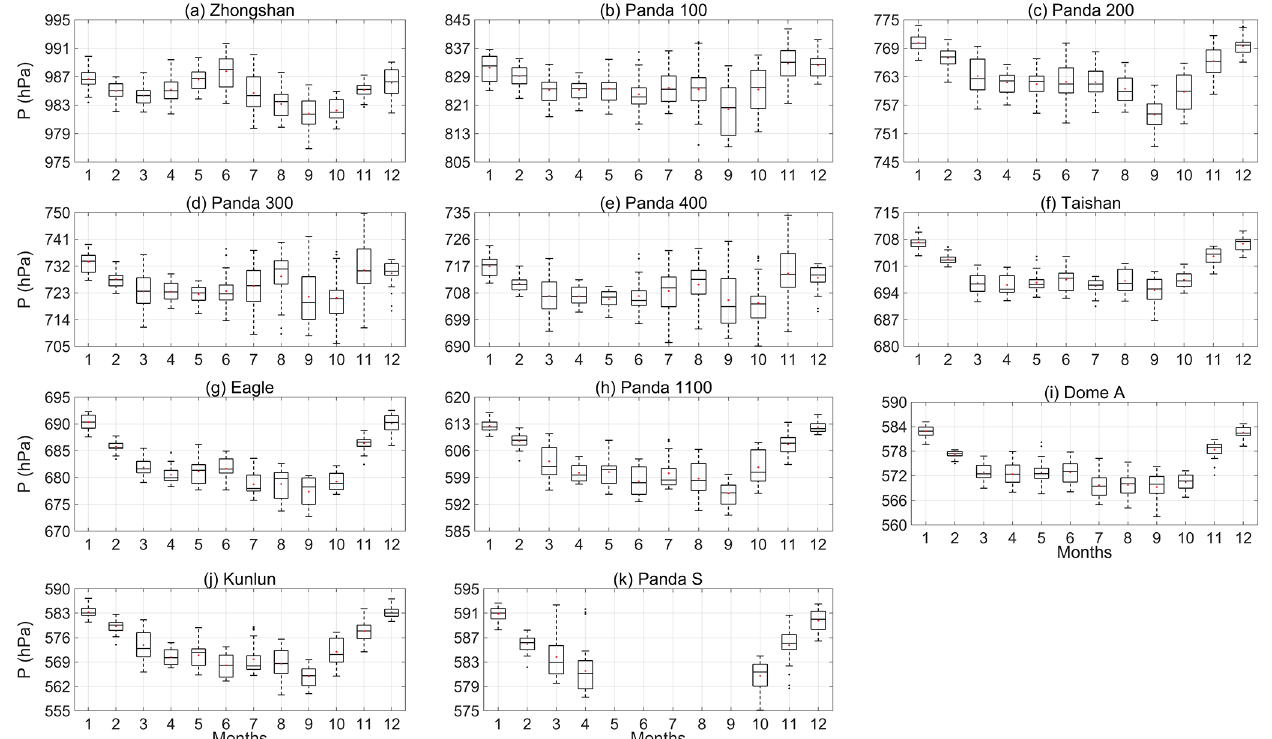
Figure 8. Monthly variation in air pressure at AWSs in the PANDA network. The calculation periods for these sites are the same as for Fig. 3.